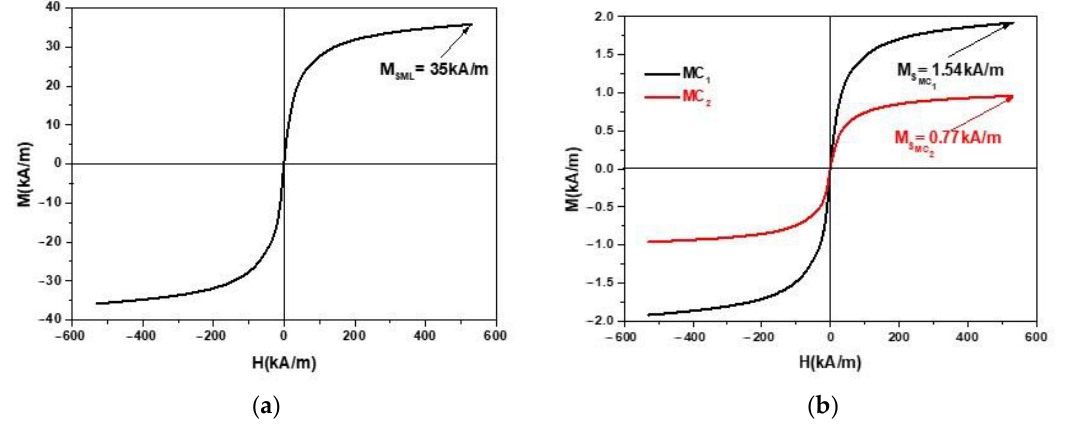
Figure 1. Optical microscopy of: ( a ) Gauze bandage GB. 1 — empty space between cotton threads, 2 — microfibers. ( b ) Whole composite material. 1 — empty space between cotton threads, 3 — microfibers impregnated with magnetic liquid ML. ( c ) Fabric’s thread. 1— microfibers impregnated with ML (at a higher magnification), 2 — interstitial space.